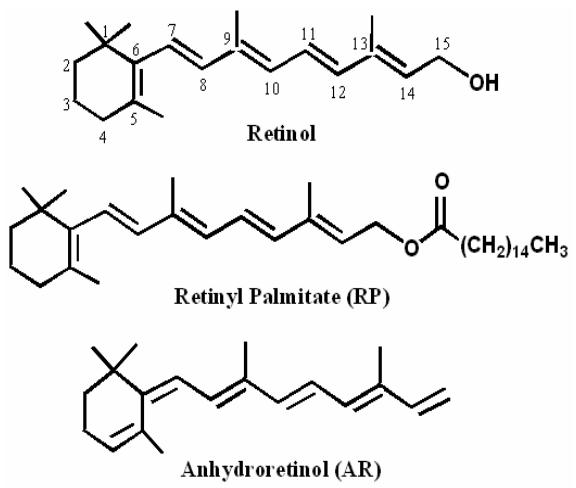
Figure 1: Structures, names, abbreviations, and numbering of retinol, retinyl palmitate (RP), and anhydroretinol